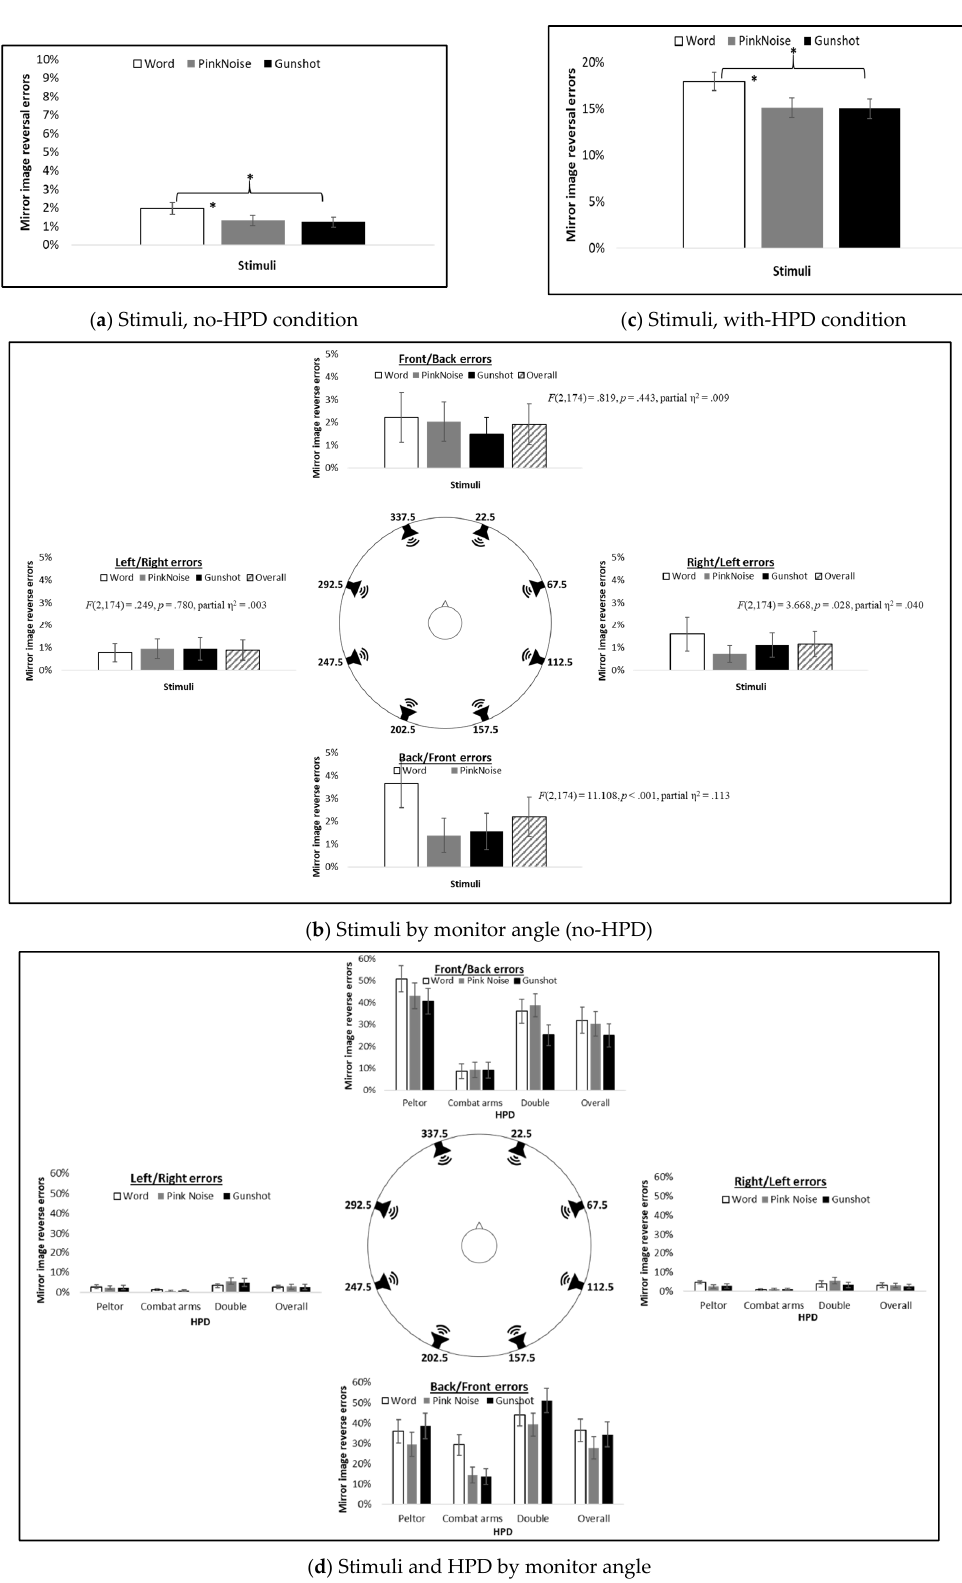
Figure 6. Mean percent of mirror image reverse errors for ( a ) stimuli only (no-HPD condition), averaged across all 90 participants; ( b ) stimuli only (no-HPD condition) at each hemifield, averaged across all 90 participants, including statistics for main effect for stimuli in each hemifield; ( c ) stimuli only (with HPD condition), averaged across HPDs, for all 90 participants; and ( d ) stimuli and HPD at each hemifield, averaged across 30 participants in each HPD group. * p <